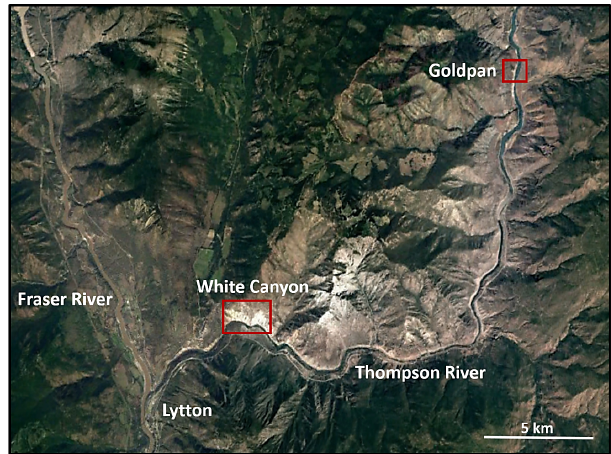
Figure 1. Aerial imagery showing the location of the White Canyon and Goldpan field sites situated along the Thompson River, near the town of Lytton in south-central British Columbia. This region is approximately 160 km northeast of the city of Vancouver. (Image source: © Google Earth; Digital Globe